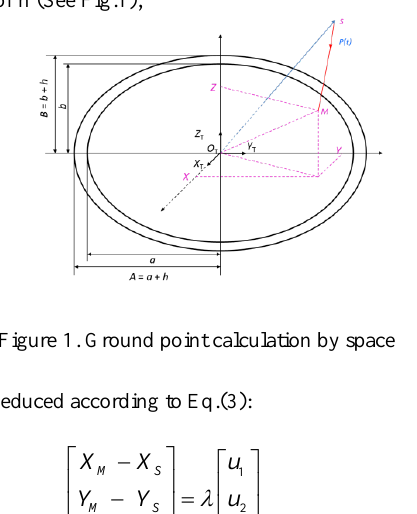
Planets can be considered as an ellipsoid which is formed by rotation around its rotational axis. We define the equatorial radius of a planet is a and the polar radius is b; assuming that a ray from the perspective center S(Xs, Ys, Zs) intersects the planet at a ground point M(XM,YM,ZM) which has an elevation of h (See Fig.1),